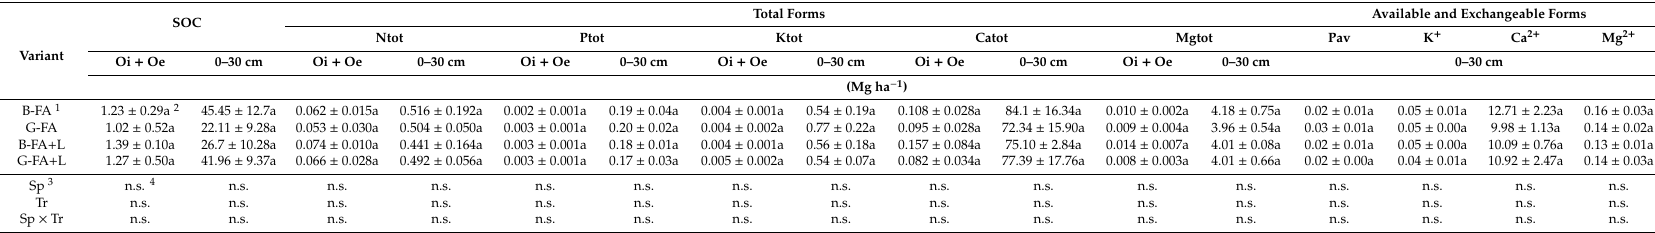
B-FA + L—variant with black alder planted in combustion waste with lignite addition in planting holes; G-FA + L—variant with grey alder planted in combustion waste with lignite addition in planting holes; 3 mean ± SE, within columns, means followed by the di ff erent letter (a, b, c) are significantly di ff erent; 4 Sp—tree species; Tr—soil treatment; Sp × Tr—interaction alder species and soil treatment; 5 results of two-way ANOVA for the e ff ect of species and treatment, i.e.,: n.s.—di ff erences not significant ( p = 0.05); 6 SOC in freshly deposited fly ash = unburned carbon content (Külaots et al. 2004). Table 2. Carbon and macronutrient (N, Ca, Mg, K and P) stocks in combustion waste technosols developed after 10 years of growth of two alder species, planted either with or without lignite